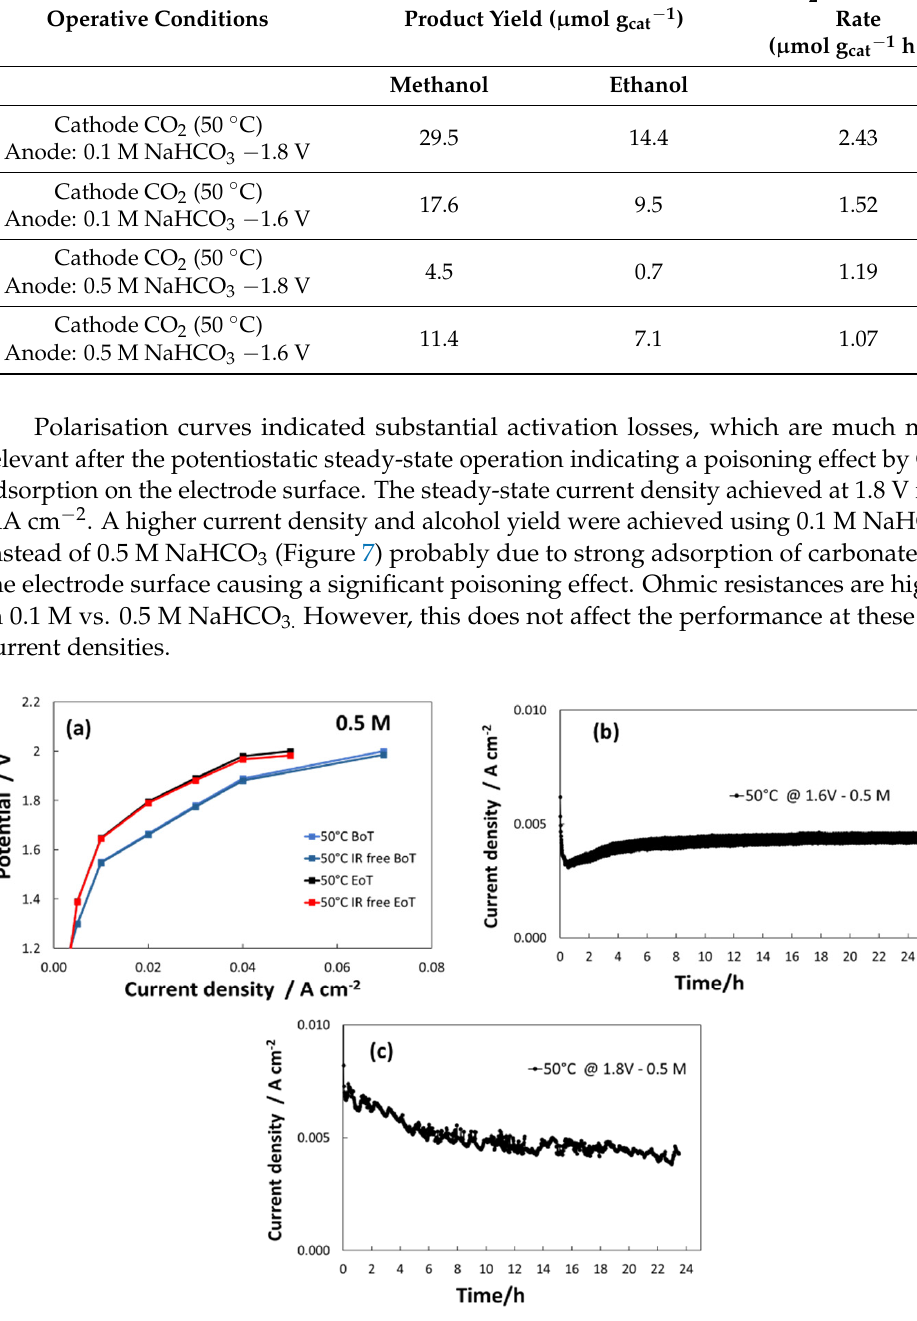
Figure 7. Polarization curves at 50 ◦ C ( a ) CuOx/KB-Sustainion X37-50 -NiFeO x /KB (BoT Rs = 0.32 Ohm cm 2 and EoT Rs = 0.2 Ohm cm 2 ) ( b ) chrono-amperometric curve at 1.6 V in presence of CO 2 in presence of 0.5 M NaHCO 3 . ( c ) chrono-amperometric curve at 1.8 V in presence of CO 2 and in presence of 0.5 M NaHCO 3 .